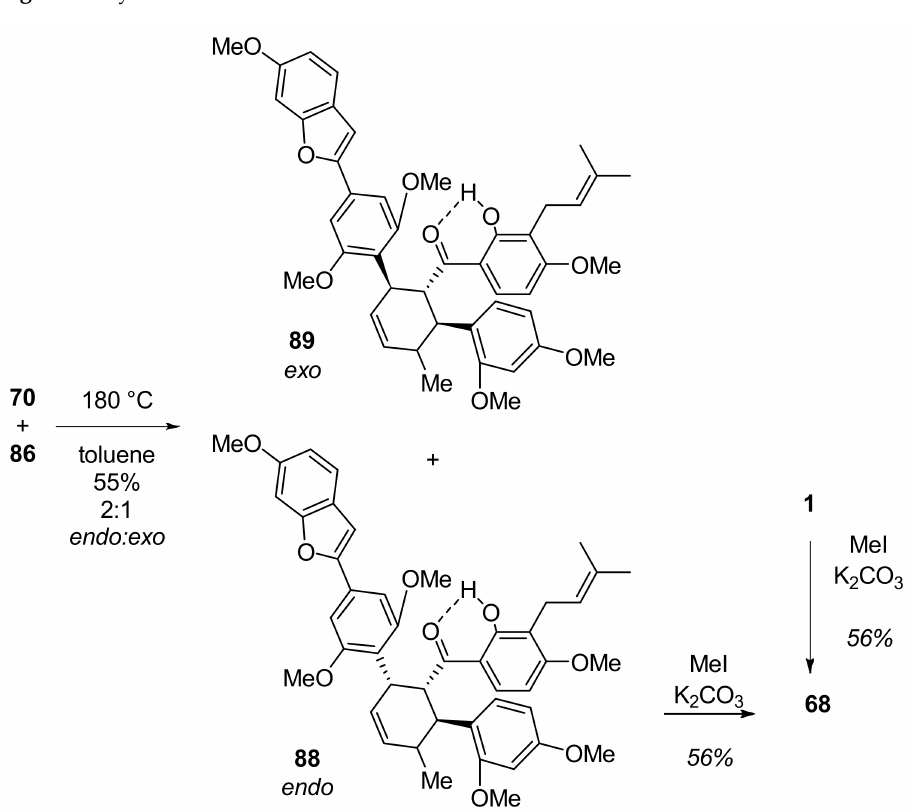
Figure 26. Diels–Alder reaction between 70 and chalcone 86 towards chalcomoracin heptamethyl ether ( 68